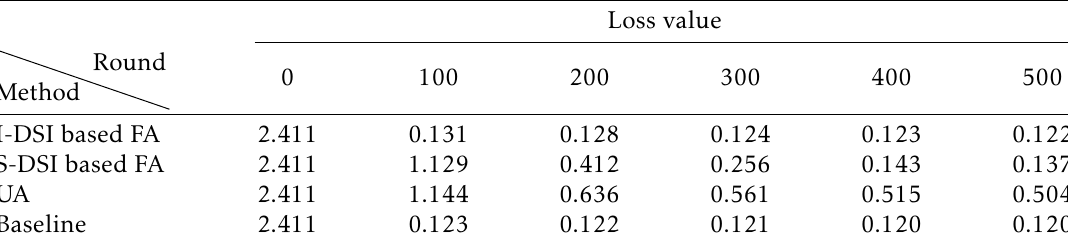
Table 4. Fault detection accuracy of various FA schemes with MNIST and delay limit β